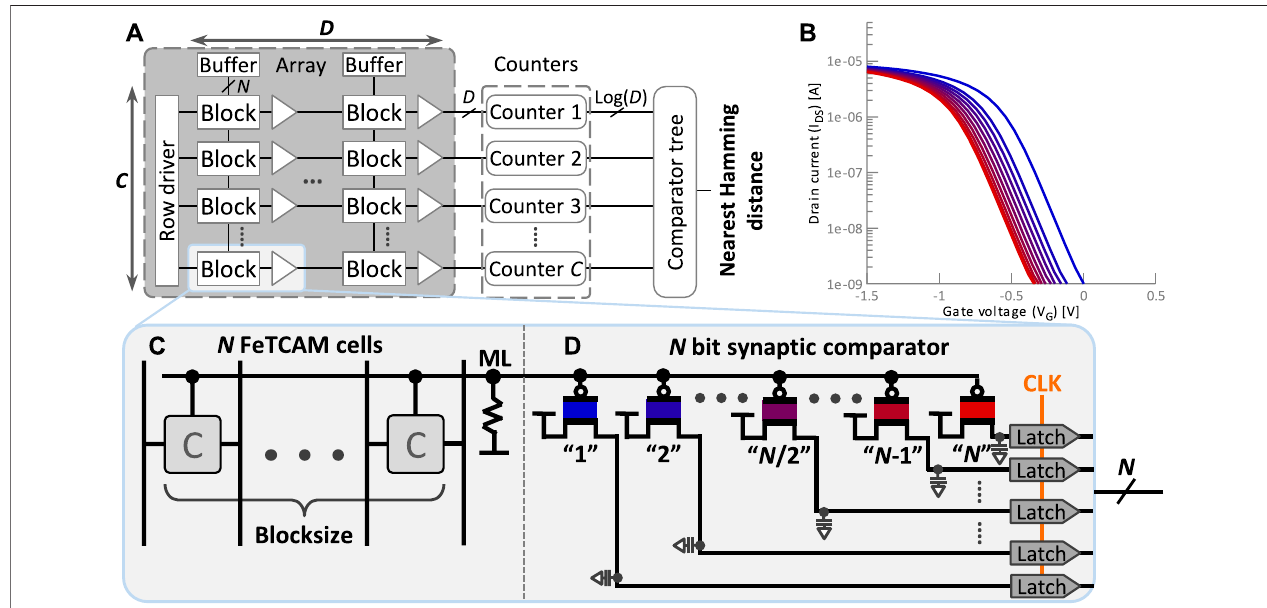
FIGURE4|(A) Sketchofpossiblelayoutwith C rowsfortheclassHDvectorseachofdimension D cutintoblocksofsize N Imanietal.(2017). (B) I D - V G plotwiththe intermediatestatesofthep-typeFeFETsynapse. (C) SingleFe-TCAMblockwith N cells. (D) Ourproposedsynapticcomparatordecodingtheanalogdischargerateofa N cell TCAM block into